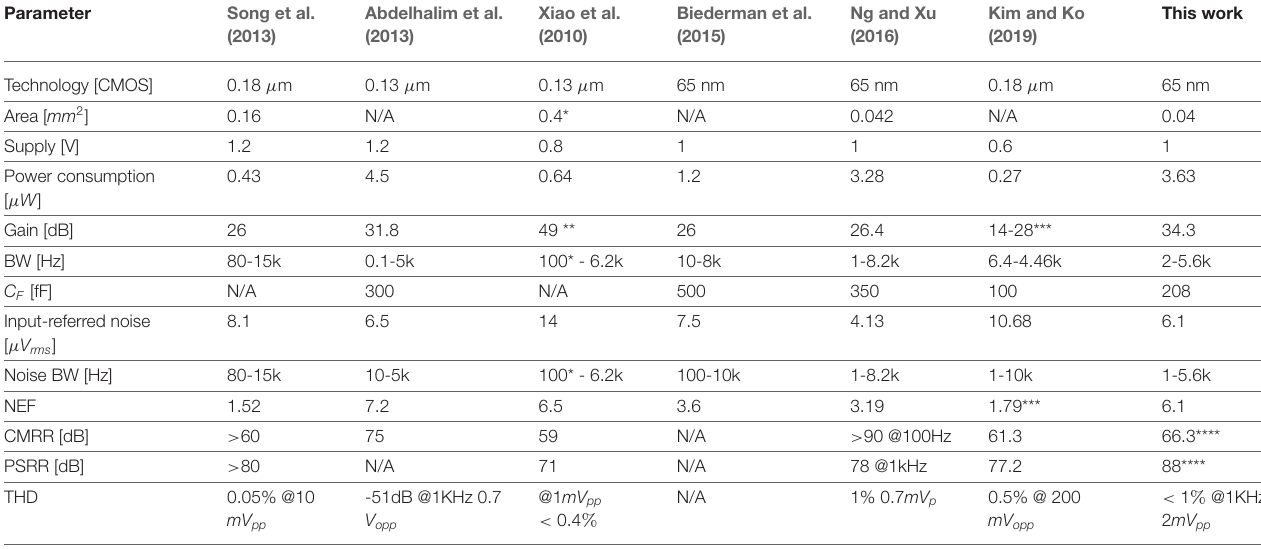
TABLE 4 | Comparison of fully integrated neural amplifiers. Parameter